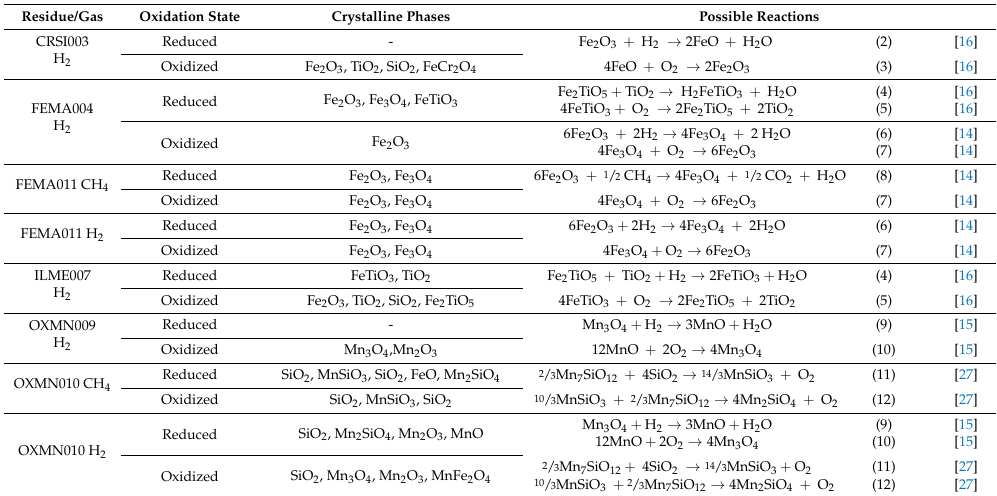
Table 4. Crystalline phases in reduced and oxidized OC